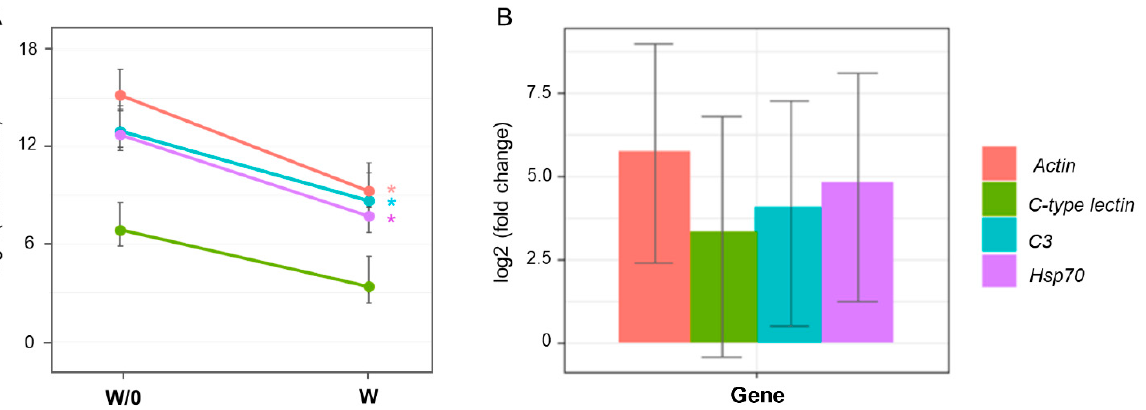
Figure 6. ( A ) Changes in expression levels of the analyzed genes (log2-transformed) between coral fragments not infested (W/0) and infested with Waminoa sp. (W). Significant differences in the gene expression abundance are indicated with asterisks. ( B ) Modulation of each gene as fold change. Fold changes were calculated with respect to levels detected in “W” fragments and were log2-transformed. In both graphs, data are expressed as means ( n = 5).